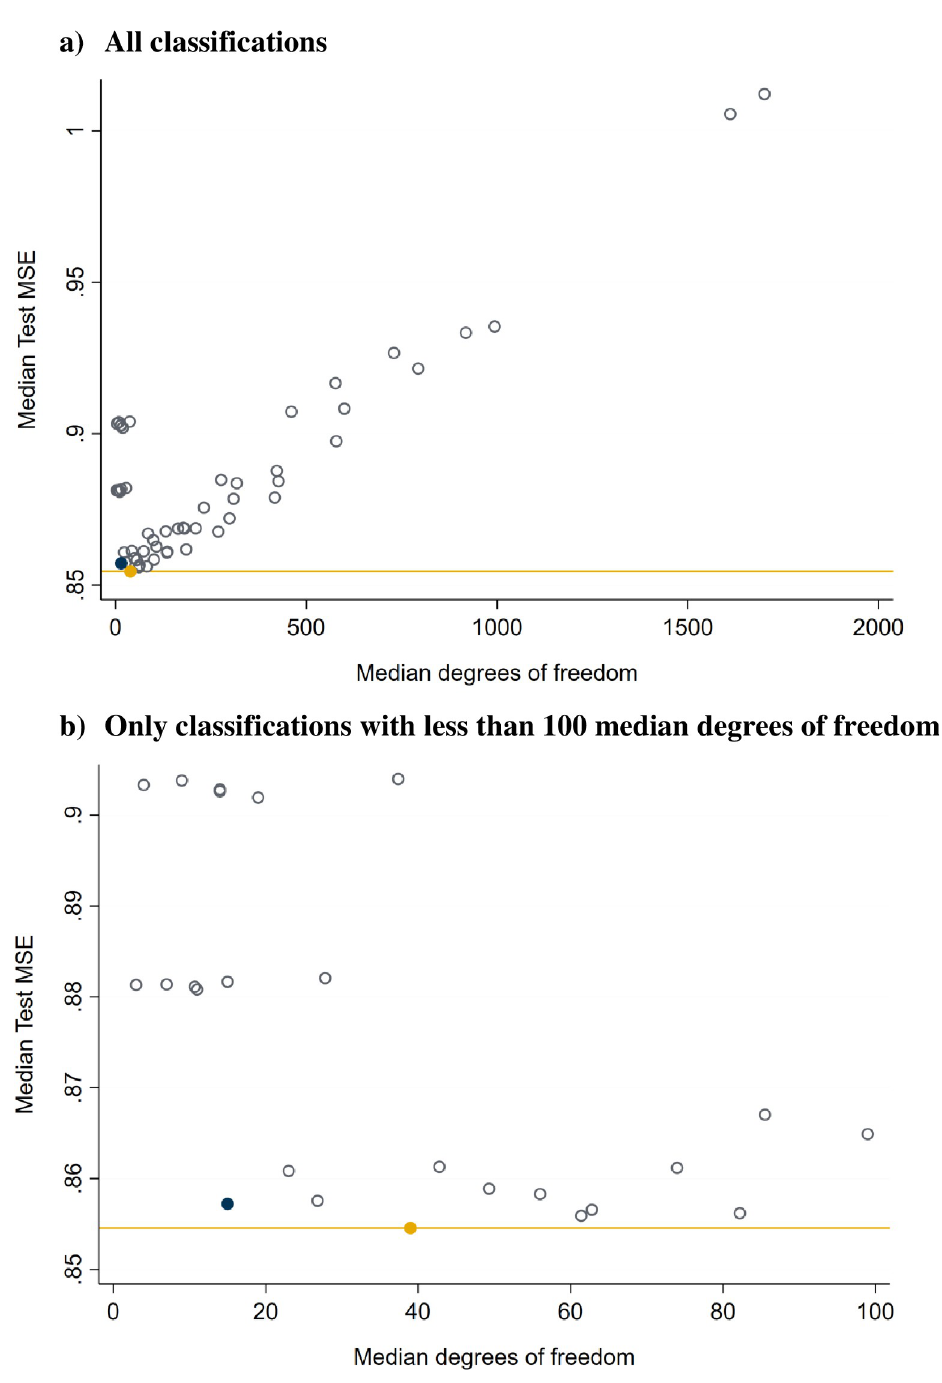
Fig 3. Median MSE across experiments for each of the 54 classifications tested, plotted against the average degrees of freedom used by a given classification. A) All classifications. b) Only classifications with less than 100 median degrees of freedom. Note: The yellow horizontal line is drawn at the minimum averaged MSE across the 54 different classifications. The yellow circle marks the best fitting classification. The blue circle is the most parsimonious classification that is closest to the minimum averaged